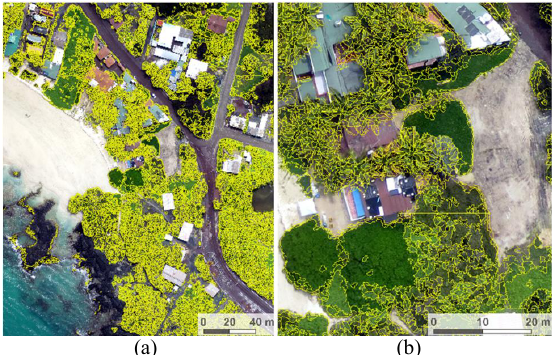
Figure 7. Segmentation. (a) For the whole region of interest and (b) for a detailed region